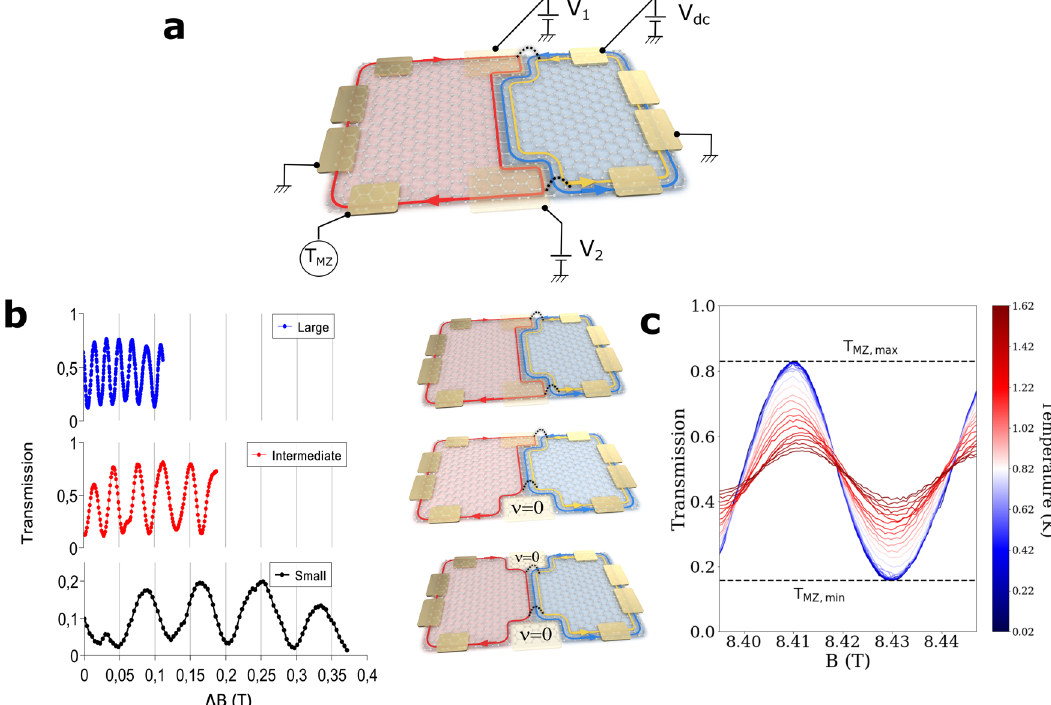
Fig. 1 | Experimental setup and Aharonov-Bohm oscillations. a Schematic representation of the PN junction. The N region is depicted in blue, the P one in pink. Electrons are injected from the upper right ohmic contact by applying a bias voltage V DC , and electron transmission T MZ is measured at the lower left contact. b Left panel: T MZ with respect to change Δ B of the magnetic fi eld. Its oscillation period decreases as the interferometer length increases. Right panel: Schematic view of the Mach-Zehnder interferometer. At the beam splitters (dotted curves), mixing between the spin-up channels having opposite valley-isospin occurs. In the